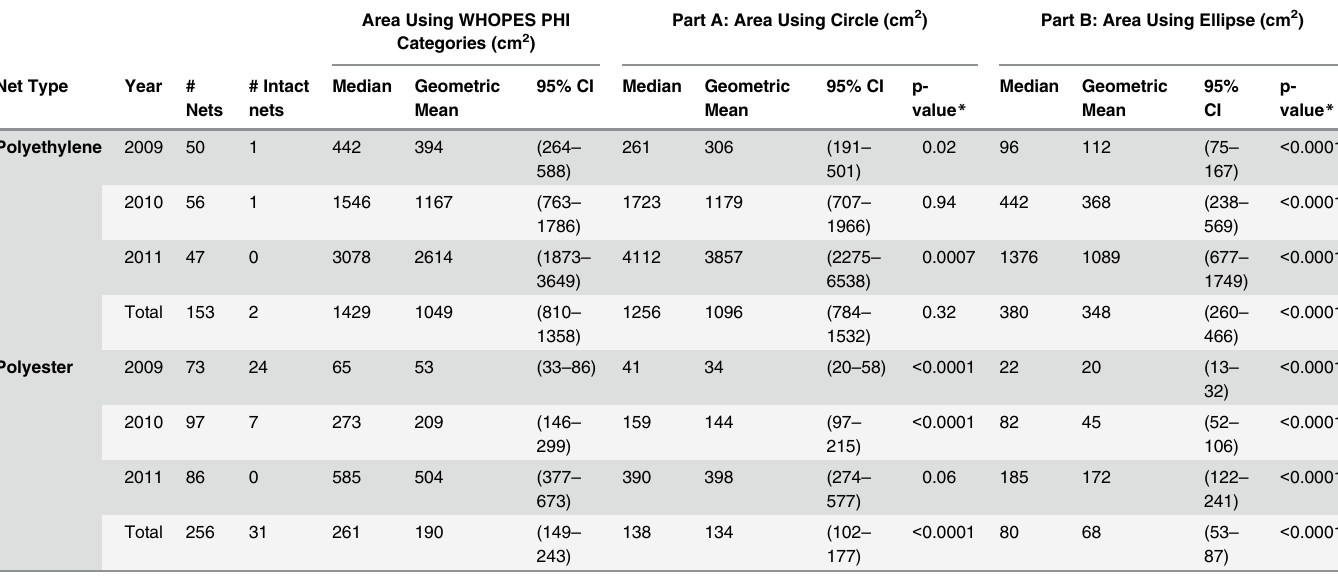
Table 3. Average total net surface area covered with holes by net type and year among nets with holes. Part A: Area Using Circle (cm 2 ) Part B: Area Using Ellipse (cm 2 Area Using WHOPES PHI Categories (cm 2 )